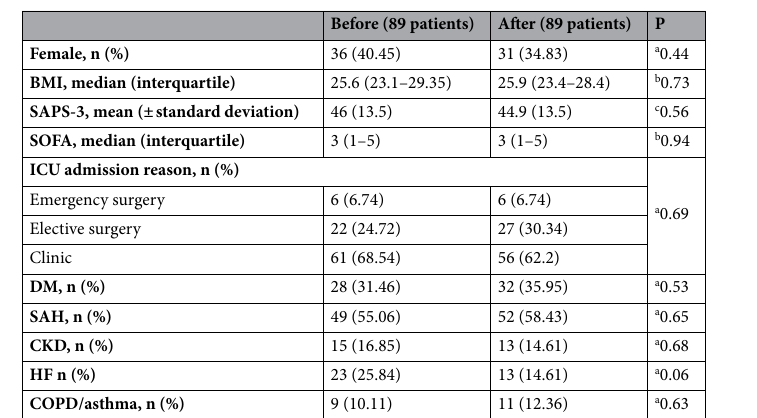
Figure 3. Study sample flowchart.